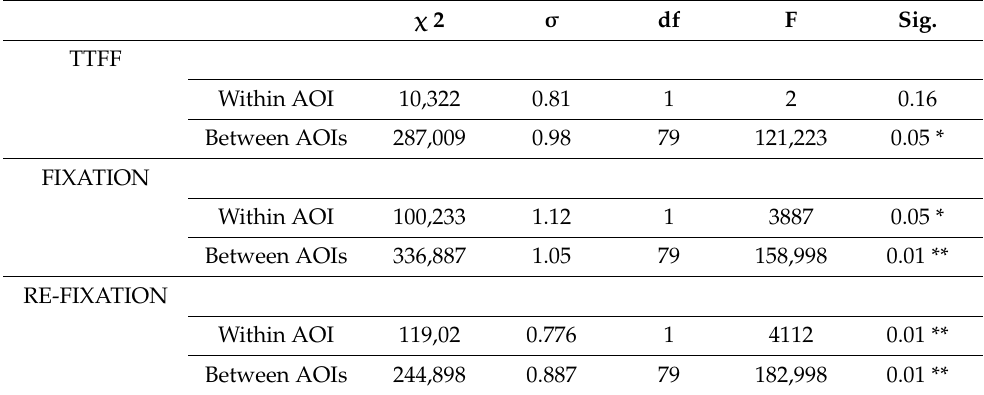
Table 3. AOI 6 ANOVA test S1 Price.